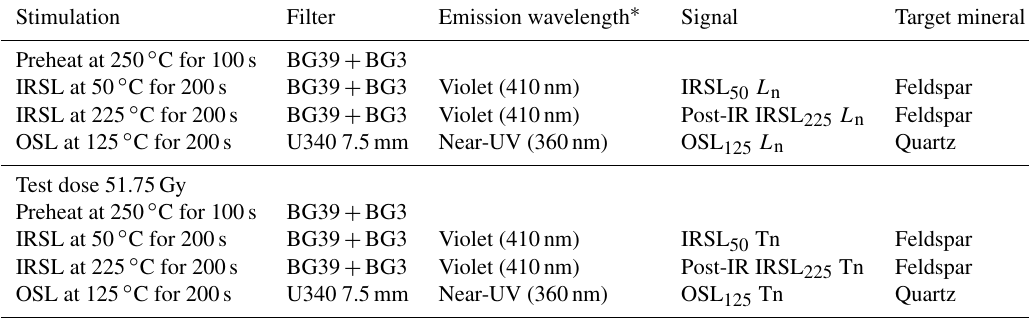
Table 2. Protocol used for measuring the luminescence signals in the rock slices. Stimulation Filter Emission wavelength ∗ Signal Target mineral Preheat at 250 ◦ C for 100s BG39 + BG3 IRSL at 50 ◦ C for 200s BG39 + BG3 Violet (410nm) IRSL 50 L n Feldspar IRSL at 225 ◦ C for 200s BG39 + BG3 Violet (410nm) Post-IR IRSL 225 L n Feldspar OSL at 125 ◦ C for 200s U340 7.5mm Near-UV (360nm) OSL 125 L n Quartz Test dose 51.75Gy Preheat at 250 ◦ C for 100s BG39 + BG3 IRSL at 50 ◦ C for 200s BG39 + BG3 Violet (410nm) IRSL 50 Tn Feldspar IRSL at 225 ◦ C for 200s BG39 + BG3 Violet (410nm) Post-IR IRSL 225 Tn Feldspar OSL at 125 ◦ C for 200s U340 7.5mm Near-UV (360nm) OSL 125 Tn Quartz ∗ Value represents the wavelength that the emission is centred